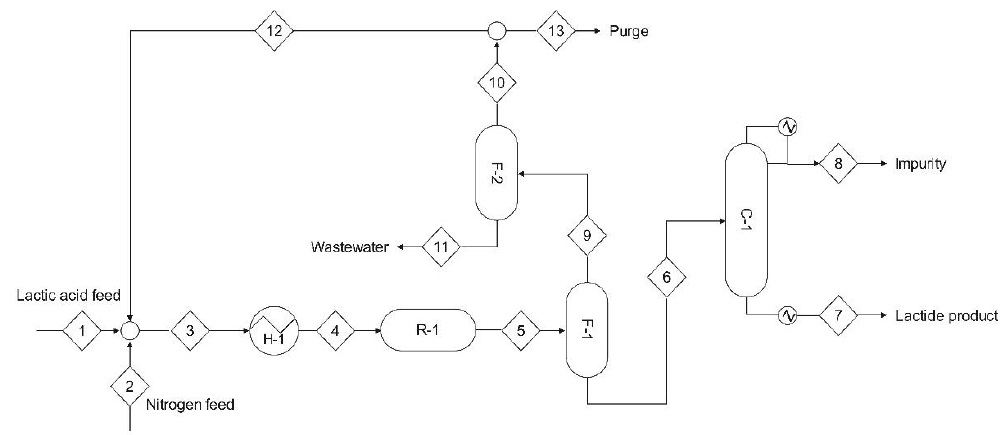
Figure 8. One-step lactide synthesis process (reprinted with permission [48], Copyright 2019 Amer- ican Chemical Society): (1) lactic acid feed stream, (2) nitrogen stream, (3) lactic acid + N 2 mixed stream, (4) vaporized mixed stream, (5) reactor outlet, (6) crude lactide stream, (7) purified lactide, (8) unpurified stream, (9) vapor outlet of the F-1 flash drum, (10) gas outlet, (11) waste water, (12) N 2 gas recycling, (13) N 2 purged, (R-1) fixed-bed plug flown reactor filled with SiO 2 /Al 2 O 3 , (H-1, F-1, F-2) heating duties, (C-1) distillation